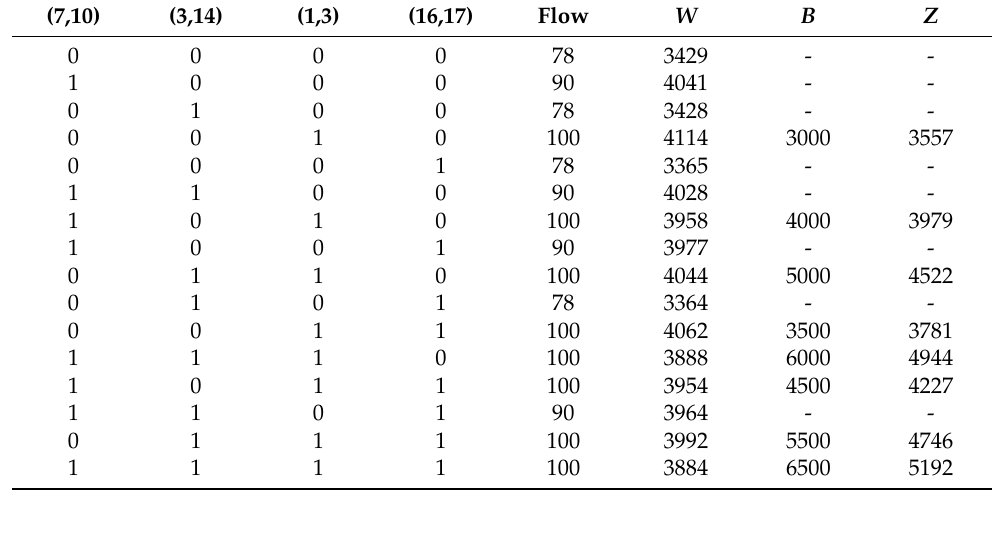
Table 6. Optimization results of the exact algorithm.